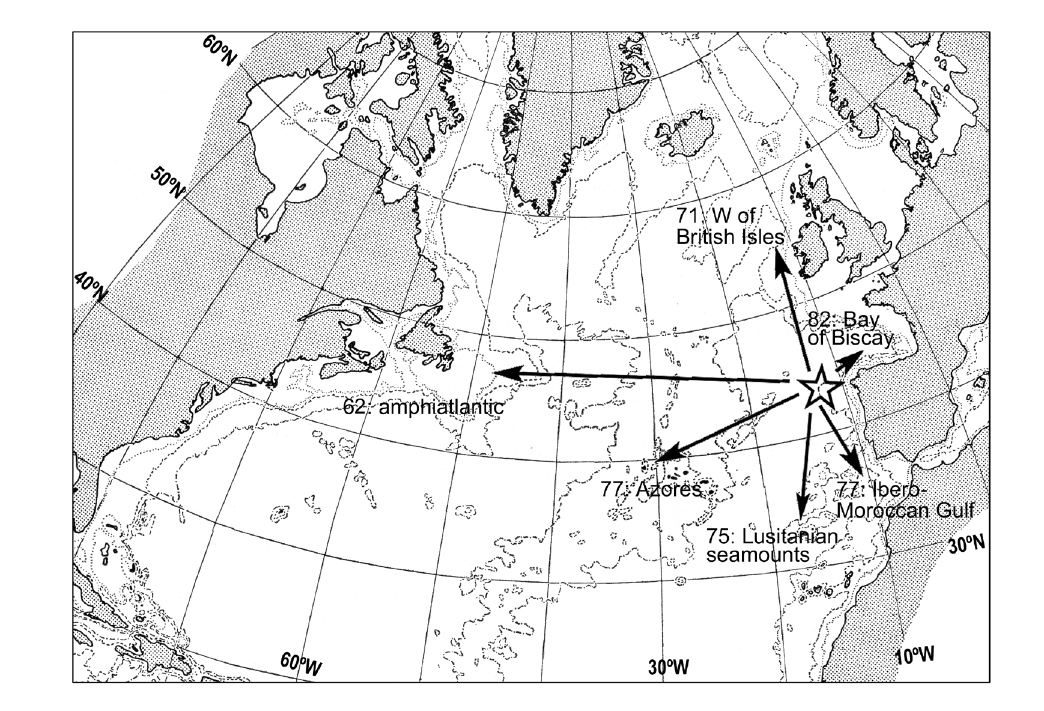
Fig. 48. Number of Galicia Bank species shared with other distant regions of the Atlantic (Bay of Biscay, Ibero-Moroccan region, seamounts of Lusitanian region and Western Atlantic).